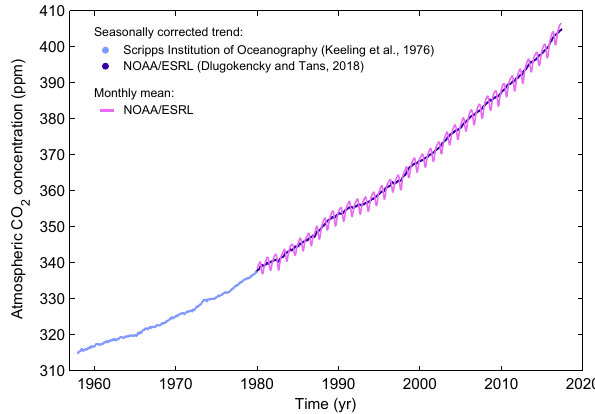
Figure 1. Surface average atmospheric CO 2 concentration (ppm). The 1980–2017 monthly data are from NOAA/ESRL (Dlugokencky and Tans, 2018) and are based on an average of direct atmospheric CO 2 measurements from multiple stations in the marine boundary layer (Masarie and Tans, 1995). The 1958–1979 monthly data are from the Scripps Institution of Oceanography, based on an average of direct atmospheric CO 2 measurements from the Mauna Loa and South Pole stations (Keeling et al., 1976). To take into account the difference of mean CO 2 and seasonality between the NOAA/ESRL and the Scripps station networks used here, the Scripps surface av- erage (from two stations) was deseasonalised and harmonised to match the NOAA/ESRL surface average (from multiple stations) by adding the mean difference of 0.542ppm, calculated here from overlapping data during